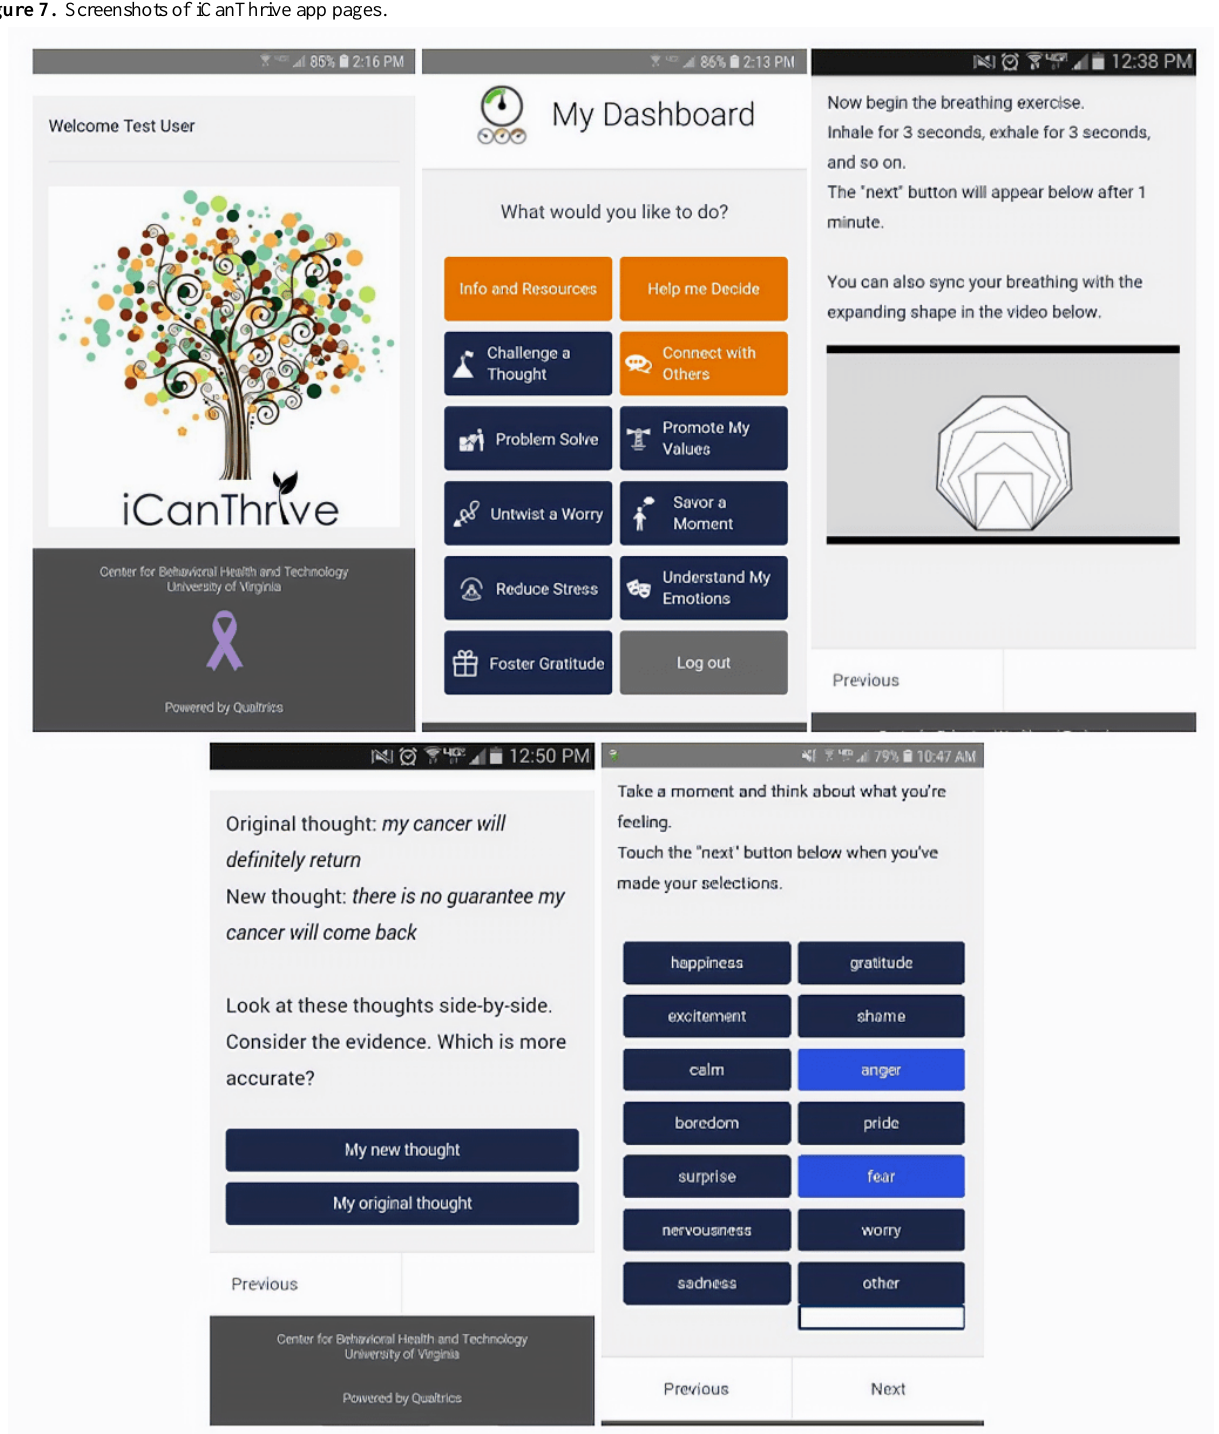
Figure 7. Screenshots of iCanThrive app